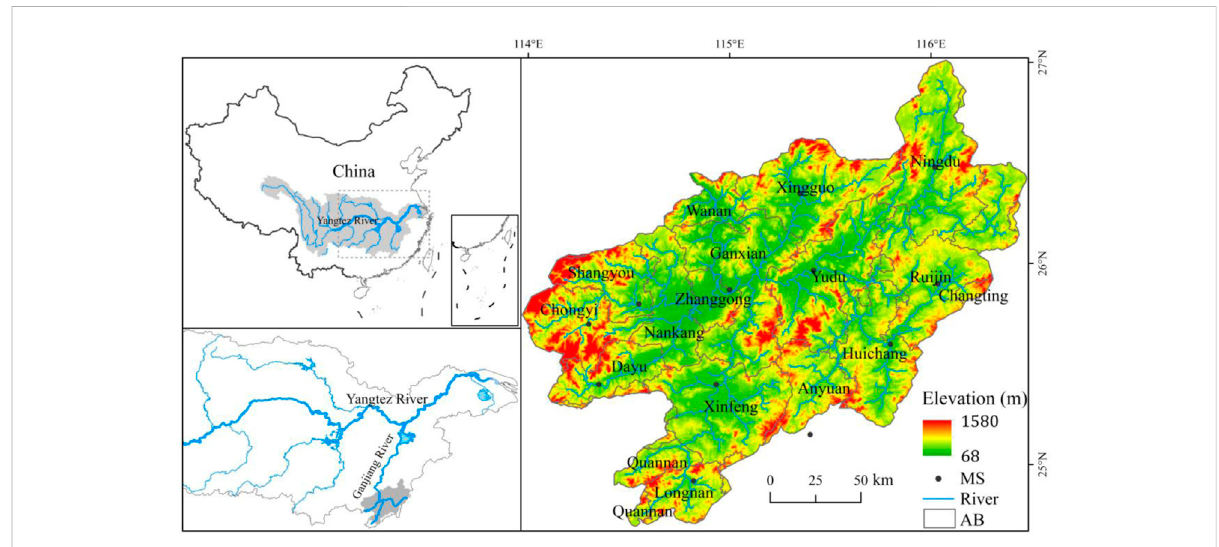
FIGURE 1 Location of the study area; MS and AB denote meteorological station and administrative boundary,